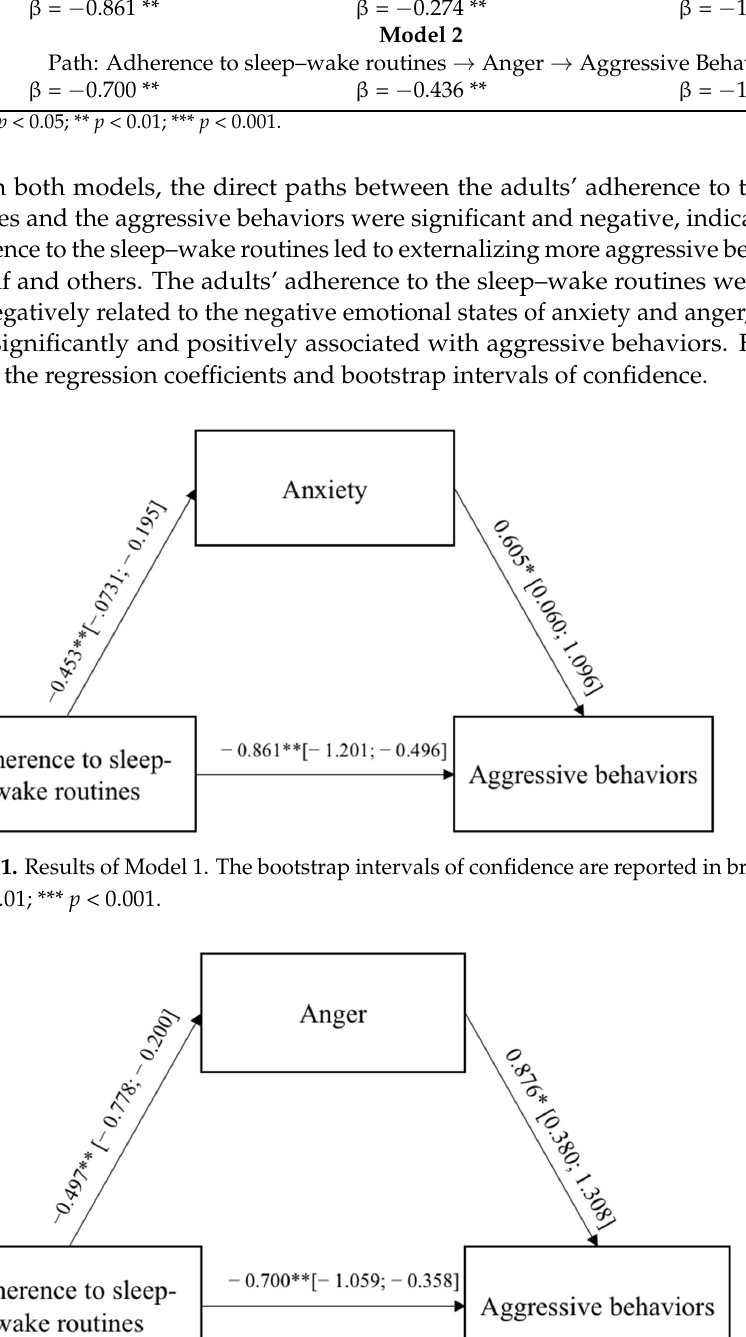
Table 6. Results of mediation Models 3 and Model 4. Direct Effect